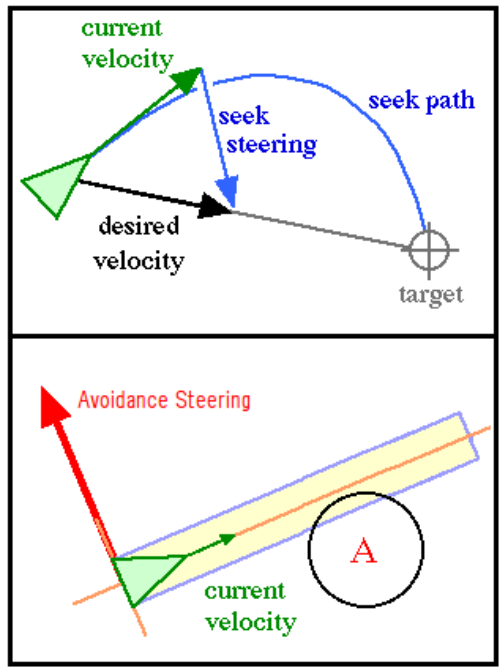
Figure 5. Steering Behaviors. Two Behaviors (Seek and Avoid) and their corresponding vectors are